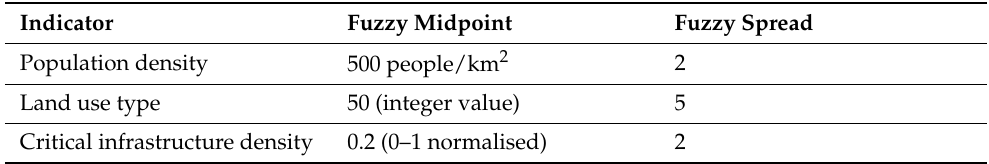
Table A4. Fuzzy midpoints and spreads for each flood exposure indicator, for ArcGIS’ fuzzification of initial data